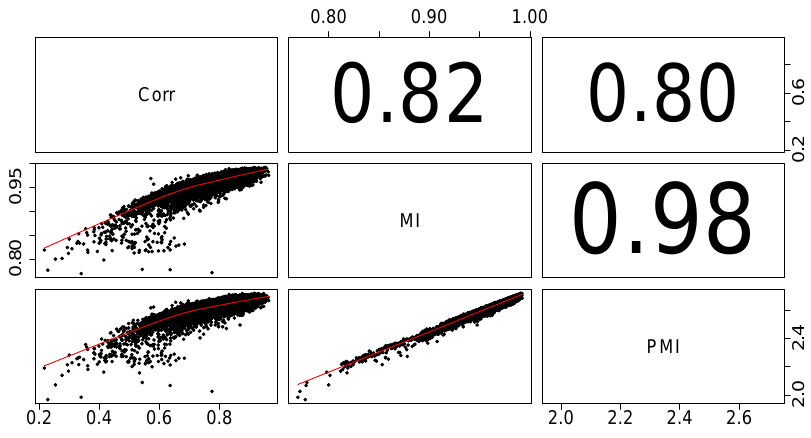
Figure 3. Pearson’s correlation coefficients between distances associated with the three used dependency measures ( δ based on Pearson’s correlation (Corr), d based on mutual information (MI) and D based on partial mutual information (PMI)) for all pairs of stocks within the studied set. It is clear that using partial mutual information changes the analysis very slightly with regards to mutual information, but both give significantly different results from the analysis using Pearson’s correlation